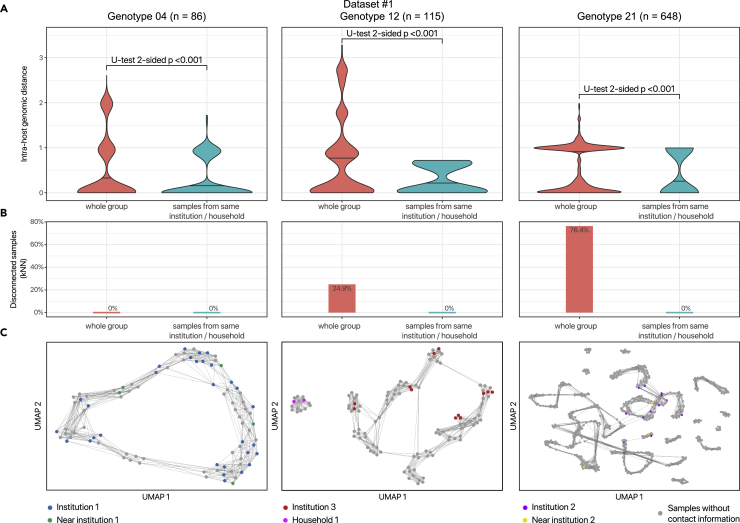
Infection dynamics revealed via characterization of intra-host genomic similarity (dataset #1)(A) The distribution of the pairwise intra-host genomic distance (computed via Bray-Curtis dissimilarity on the kNN graph, with k = 10, after PCA; see Experimental procedures) for the samples belonging to the same household or institution (including samples marked as near), versus the pairwise distance of all samples belonging to clonal genotypes G4, G12, and G21. The p values of the Mann-Whitney U test two-sided are also shown.(B) The proportion of samples that are disconnected in the kNN graph, with respect to the samples belonging to the same household or institution (including samples marked as near) and with respect to all samples.(C) The UMAP projection of the intra-host genomic diversity of the samples belonging to clonal genotypes G4, G12, and G21, returned by VERSO step #2.